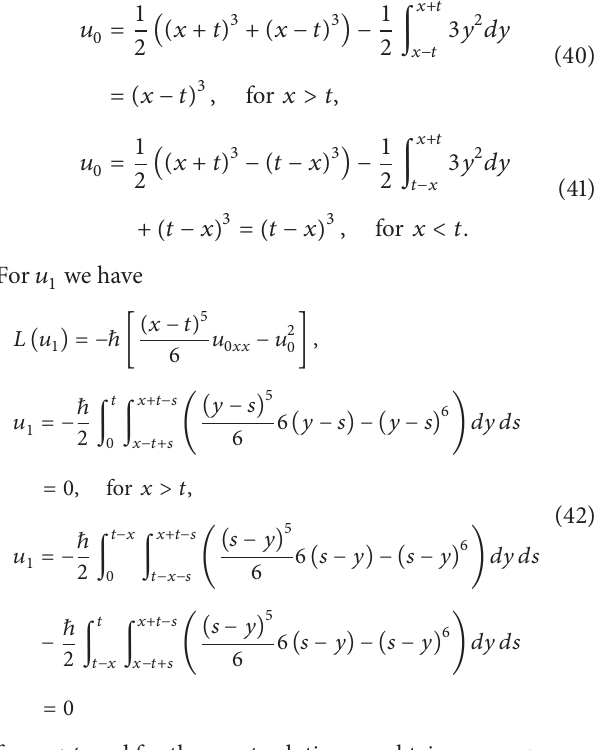
Letters A: General, Atomic and Solid State Physics , vol. 361,